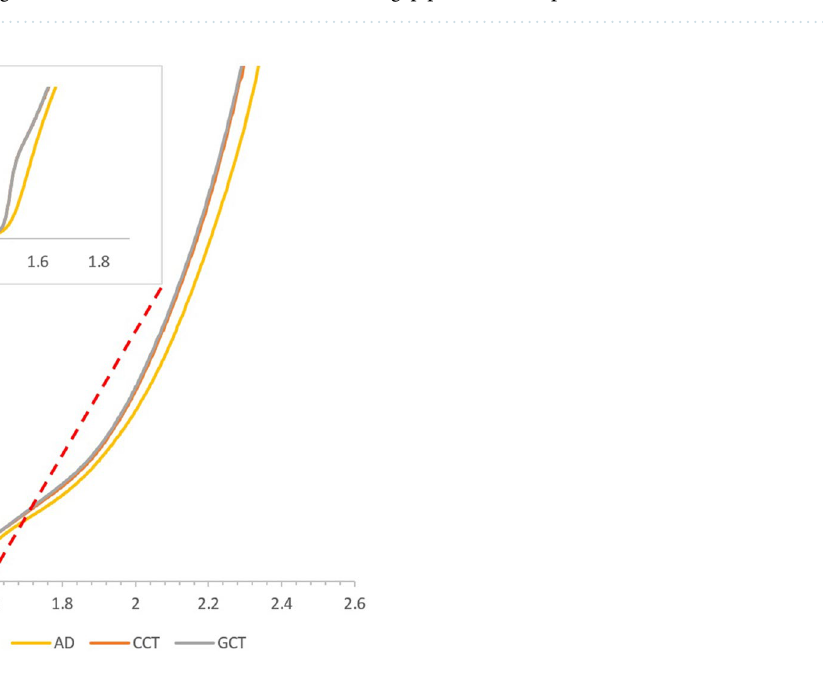
Figure 6. Optical absorption graphs for (a) as-deposited (AD) and (b) CdCl 2 -treated CdMnTe layers grown within the range of 1340 to 1450 mV. Inset is the sub-bandgap point of absorption at ~ 930 nm.